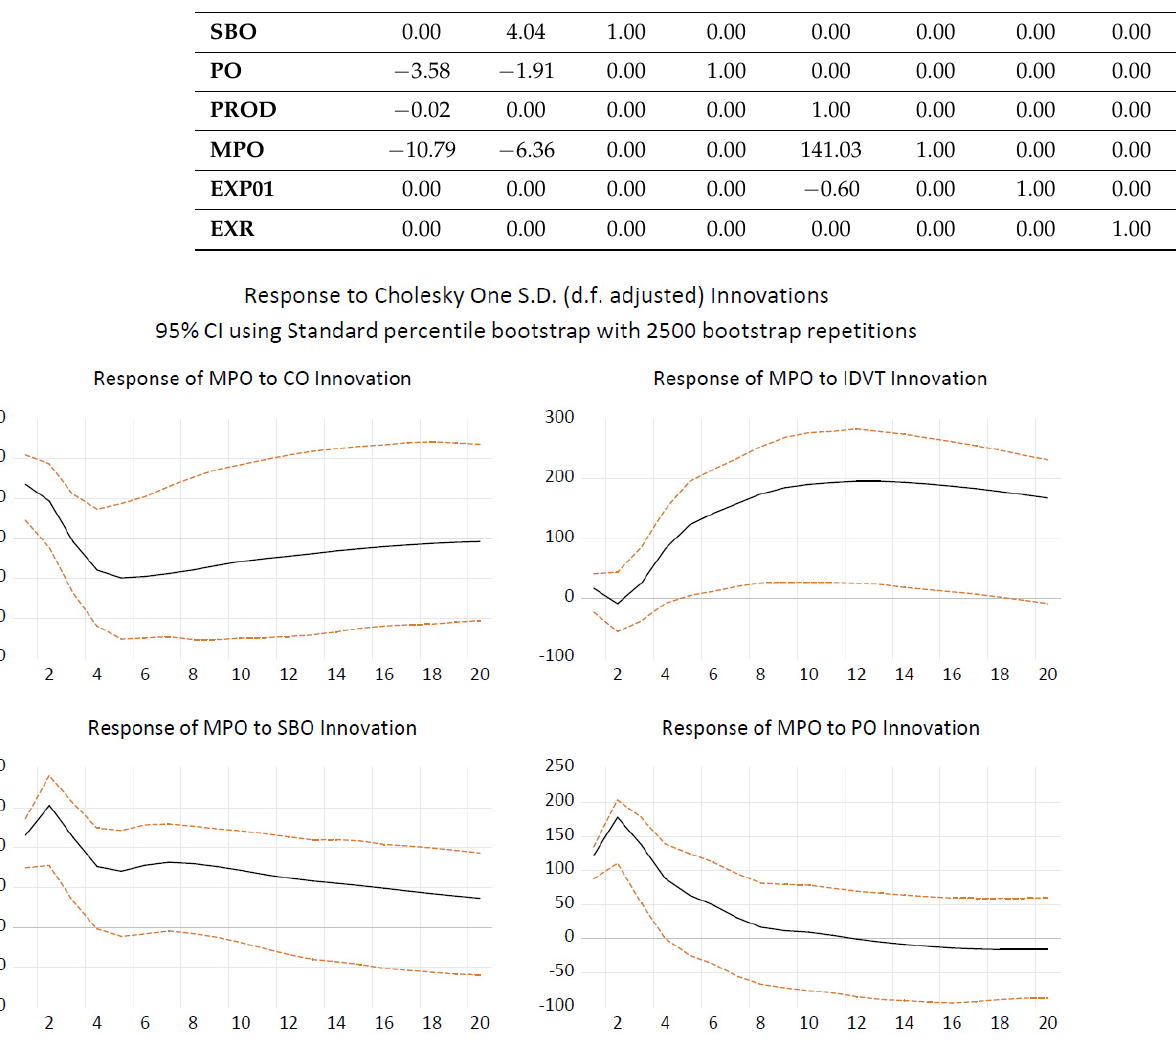
Figure 3. The impulse response of the series of interest, MPO to innovations/shocks in other exogenous variables.